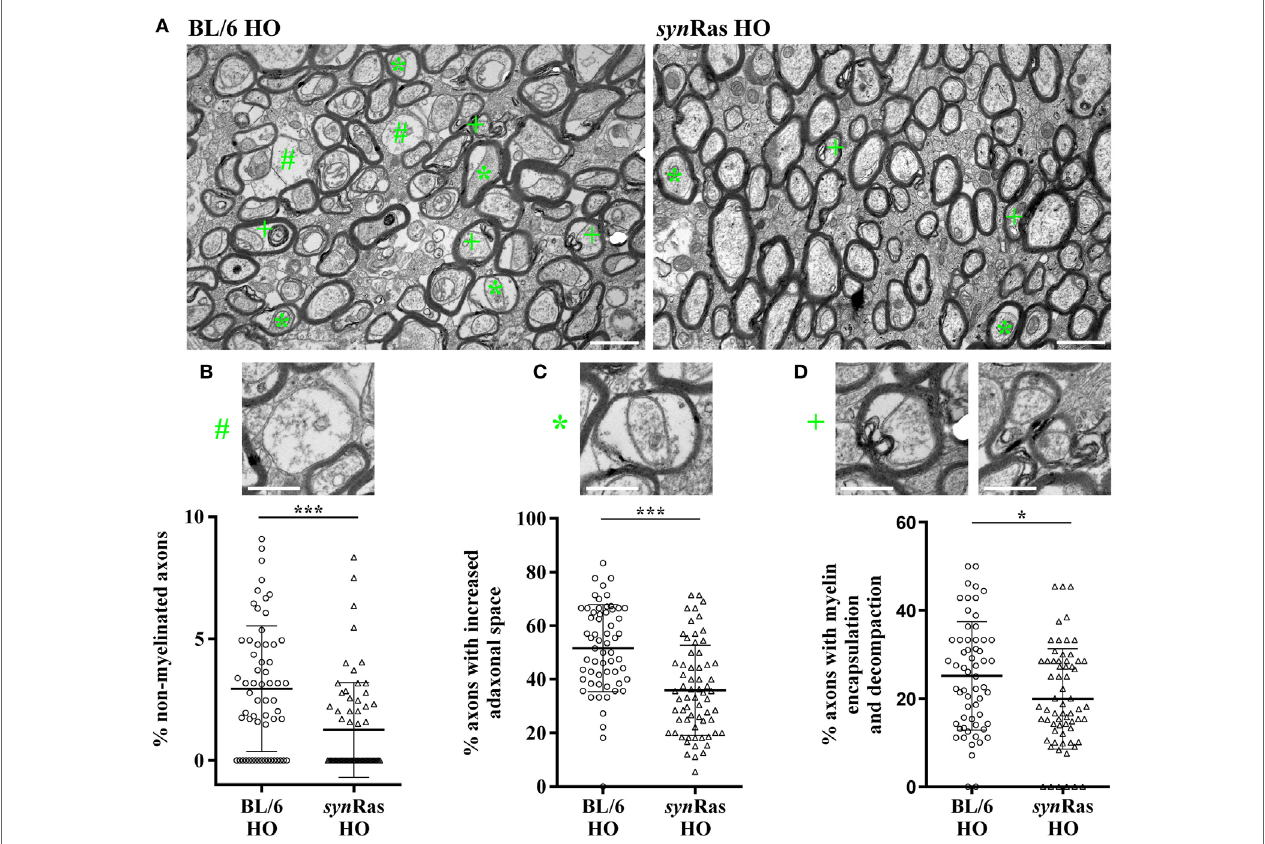
FigUre 4 | Long-lasting ultrastructural changes of myelination in hyperoxic animals are diminished in transgenic syn Ras mice. (a) Representative electron microscopy images of young adult (P42) BL/6 and syn Ras mice either exposed to normoxia [21% oxygen (NO)] or hyperoxia [24 h, 80% oxygen (HO)] at P6. Quantification of non-myelinated axons [ (B) , #], increased adaxonal space [ (c) , *], and axons with encapsulated and decompacted myelin sheets [ (D) , + ]. Alterations are exemplified in panel (a) . Scale bar in panel (a) is 1 and 0.5 µm in higher magnified images in panels (B–D) . n = 60–65 analyzed field of views (61.44 µm 2 each) derived from four mice per group (* p < 0.05 and *** p <